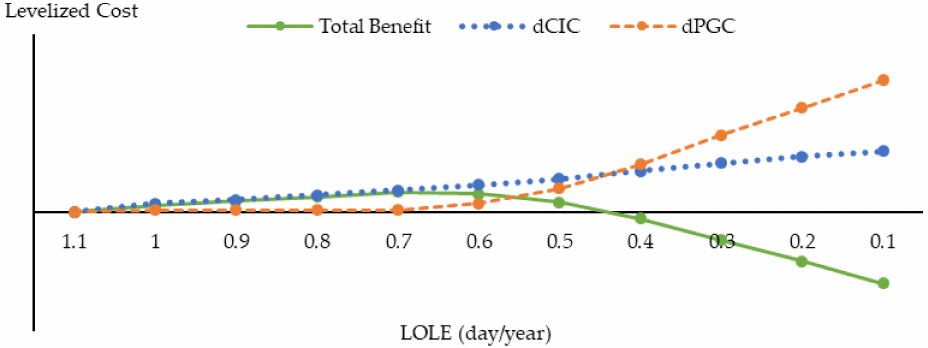
Figure 9. Total benefit associated with LOLE criterion of the case